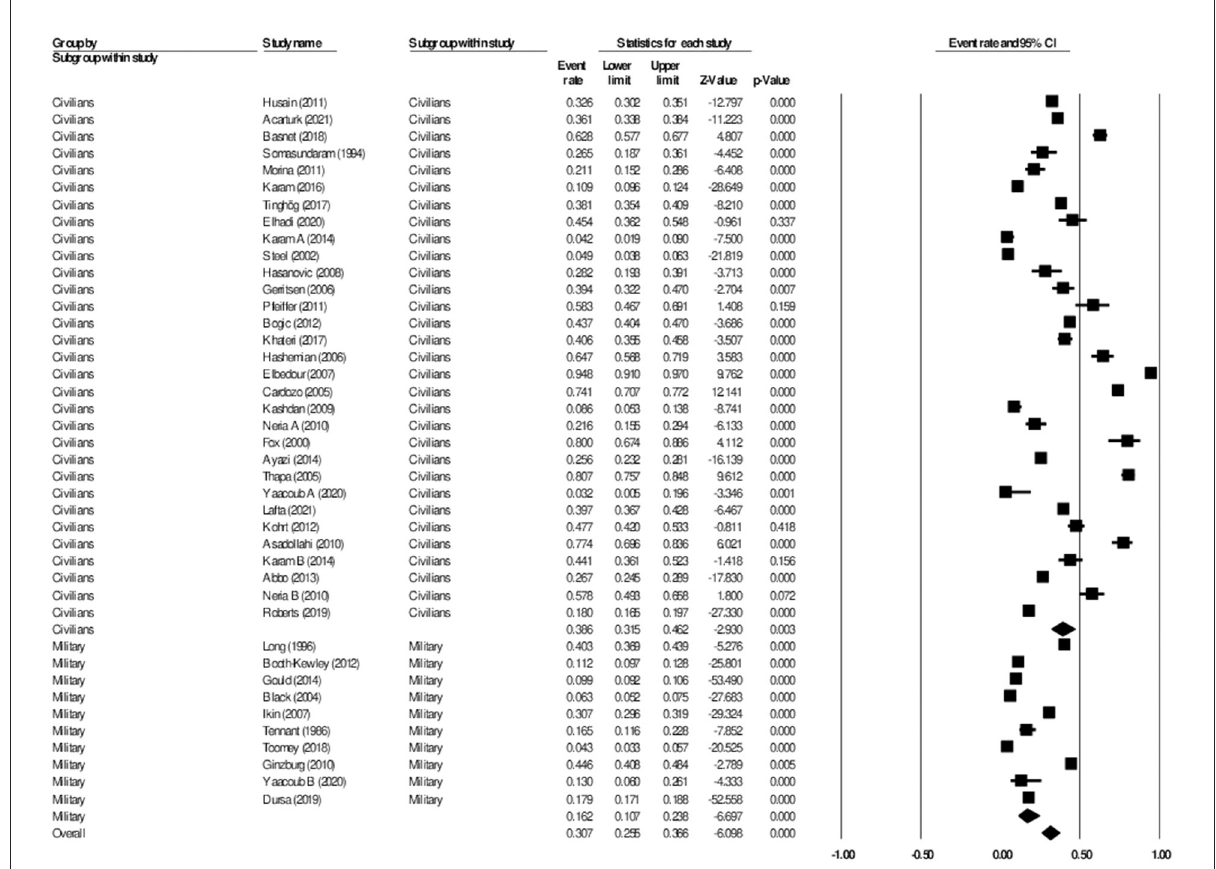
FIGURE4 Forest plot showing prevalence of anxiety, including analysis between military and civilian